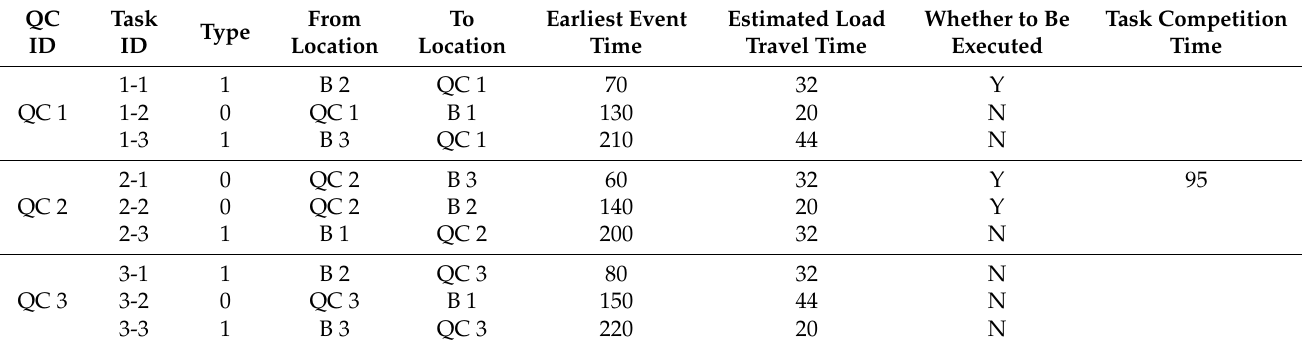
Figure 5. The decision stage demonstration in an episode. Table 6. Detailed description of the parameters of the CDA